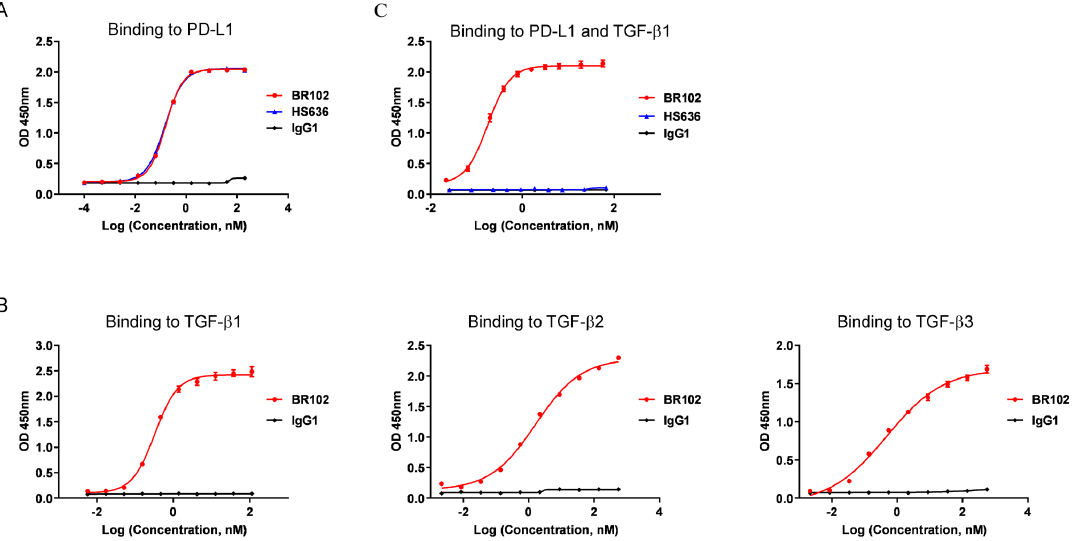
Figure 2. BR102 specifically binds to PD-L1 and TGF- β. The binding of BR102 to PD-L1 ( A ) and various human TGF- β isoforms (β1, β2 , and β3) ( B ) was determined by ELISA. ( C ) The simultaneous binding of BR102 to PD-L1 and TGF- β1.